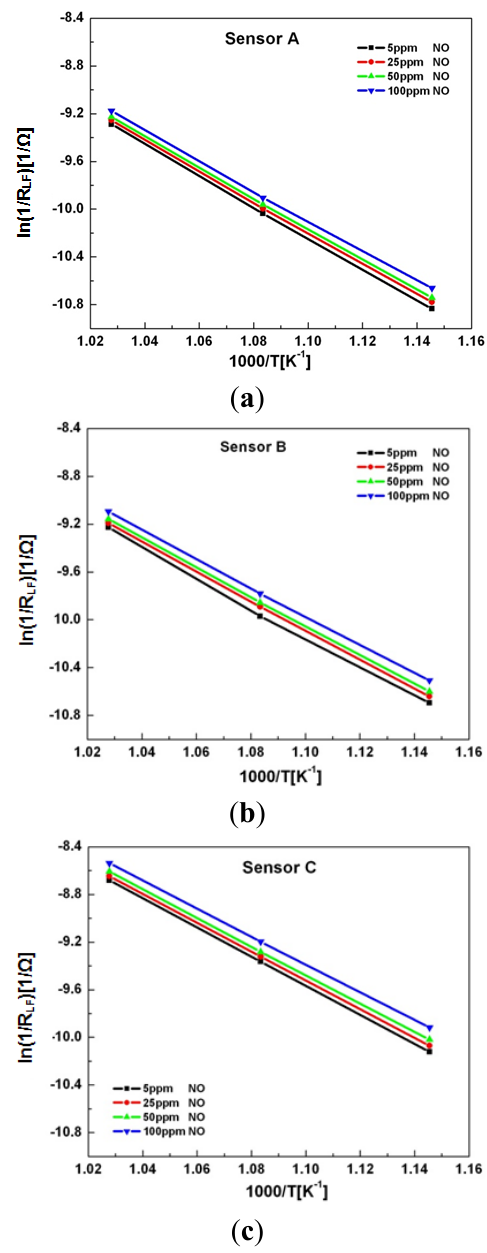
(Sensor B), and ( c ) 46% (Sensor C), while operating in 10.5% O present in a balance of N